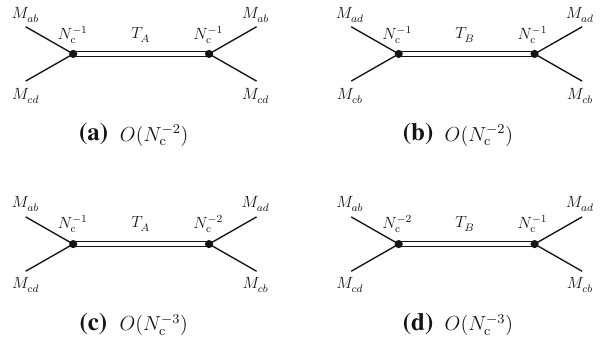
Fig. 7 Leading-order contributions of tetraquarks T direct ( a , b ) and recombination ( c , d )